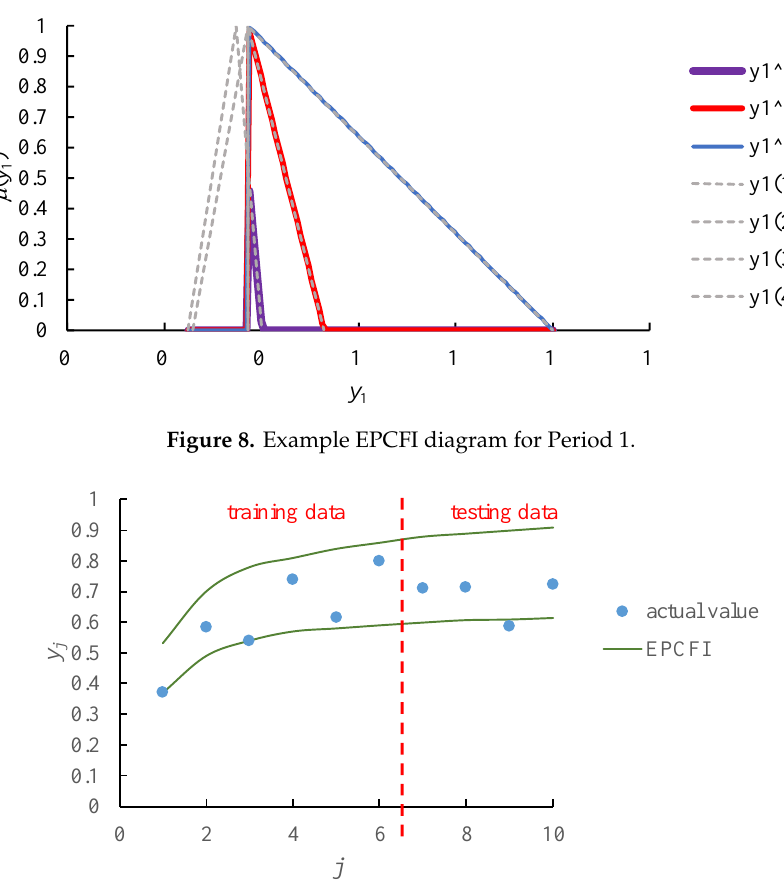
Figure 9. The aggregation results.